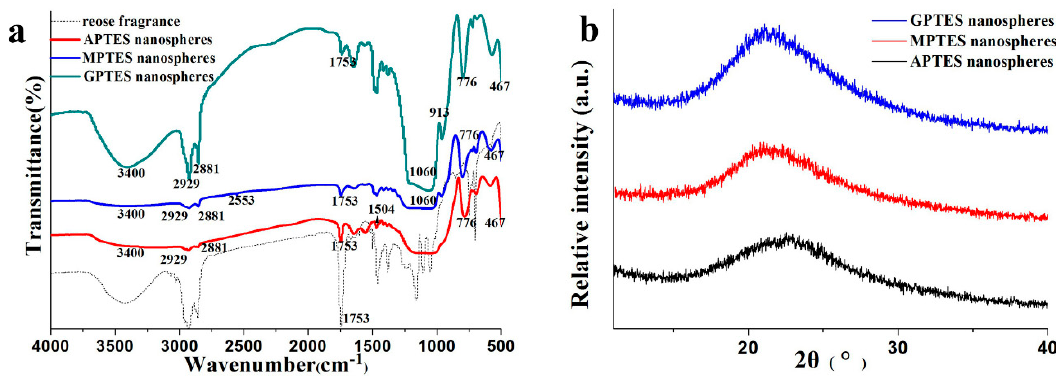
Figure 3. ( a ) Fourier transform infrared (FTIR) spectroscopy of modified SiO 2 nanospheres; ( b ) X-ray powder diffraction (XRD) spectroscopy of modified SiO 2 nanospheres.